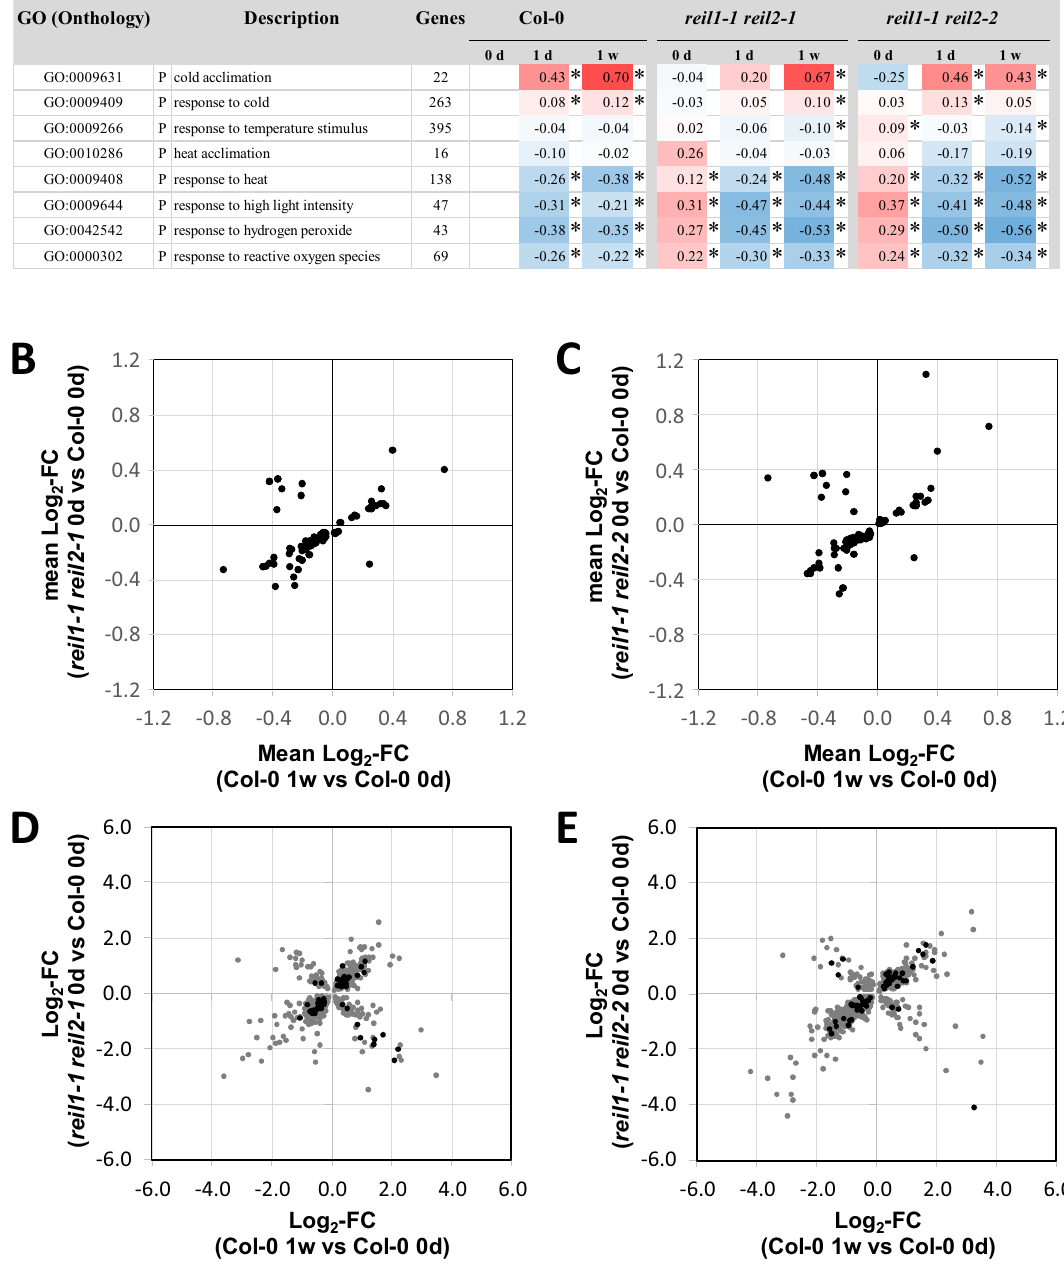
Figure 5. Functional enrichment and transcript correlation analyses of differential gene expression in the roots of Col-0, and the reil1-1 reil2-1 and reil1-1 reil2-2 double mutants in the non-acclimated state (0 day, 20 °C) and shifted to 10 °C cold for 1 day or 7 days. Differential gene expression is determined relative to non-acclimated Col-0 at optimized temperature 20 °C. ( A ) Mean log 2 -fold changes (FC) of temperature related GO terms. Significant positive or negative functional enrichments, i.e. FDR-adjusted P -values < 0.05, are indicated by asterisks. The heat map color scale ranges from log 2 -FC + 1.5 (red) to − 1.5 (blue). Mean log 2 -FC, z-scores, and FDR-adjusted P -values of gene sets from 2145 GO terms are calculated by parametric analysis of gene set enrichment (PAGE) 19 (Supplemental Table S3). ( B ) Mean log 2 -FC of shared significantly enriched GO terms from the non-acclimated reil1-1 reil2- 1 mutant (0 d) compared to acclimated Col-0 at 7 days after shift. ( C ) Mean log 2 -FC of shared significantly enriched GO terms from the non-acclimated reil1-1 reil2-2 mutant (0 d) compared to acclimated Col-0 at 7 days after shift. Note that both double mutants and cold acclimated Col-0 shared 100 GO terms of 2145 (FDR-adjusted P < 0.05). ( D ) Significantly changed transcripts of non-acclimated reil1-1 reil2-1 relative to non-acclimated Col-0 compared to significant cold-responsive transcripts of Col-0 at 7 days after cold shift (P < 0.05, gray, P < 0.01 black, heteroscedastic T-tests). ( E ) Significantly changed transcripts of non-acclimated reil1-1 reil2-2 relative to non-acclimated Col-0 compared to significant cold-responsive transcripts of Col-0 at 7 days after cold shift (P < 0.05, gray, P < 0.01 black, heteroscedastic t tests). Note that correlation coefficients are not calculated because assumptions of linear correlation do not apply to the full set of